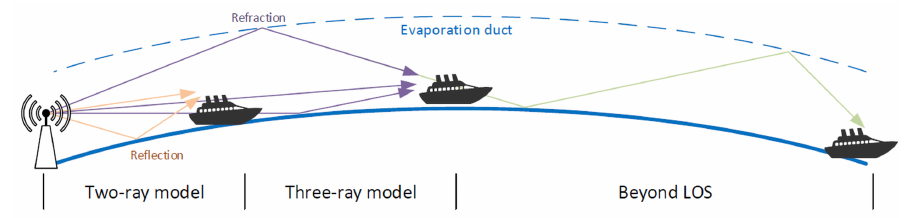
Figure 1. Difference between propagation models.